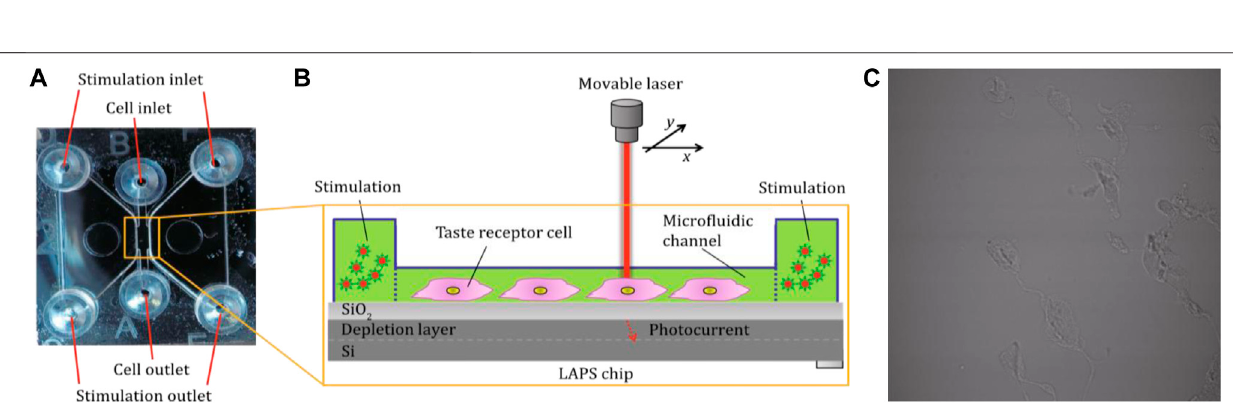
FIGURE 6 | Schematic diagram of the microchannel detection system based on the LAPS(Liang et al., 2019b).